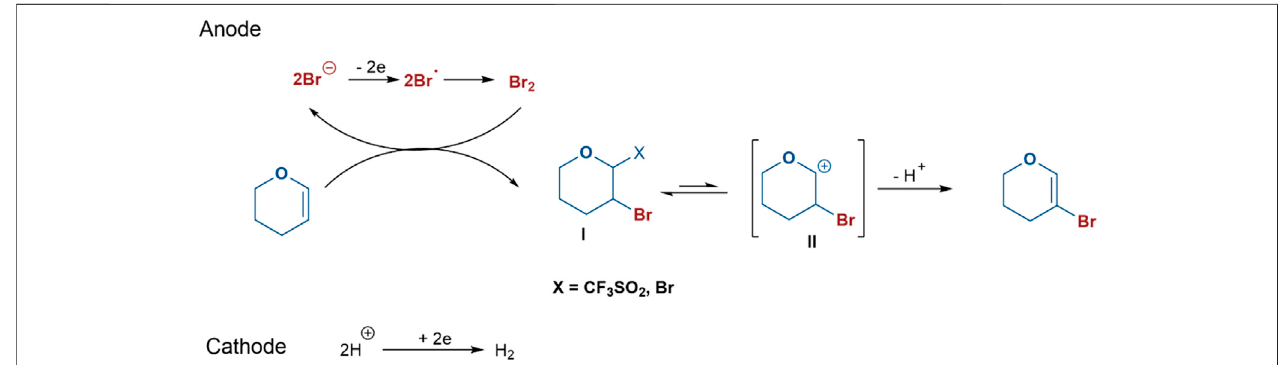
SCHEME 4 | Plausible reaction mechanism for the electrochemical bromination of glycals.